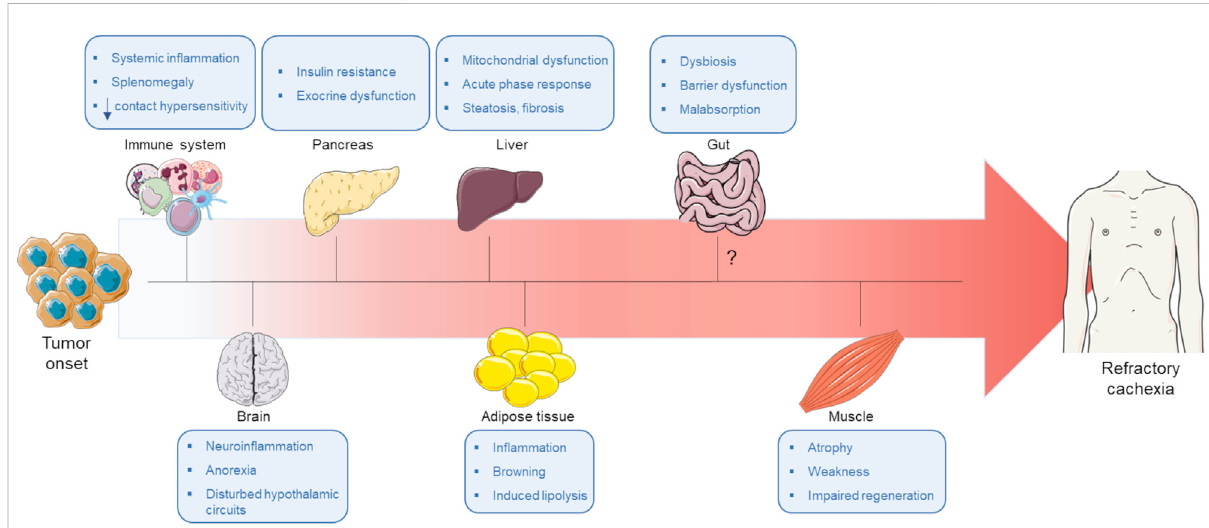
FIGURE 1 Hypothetical temporalmodelforcachexiaprogressionbyintegrating fi ndingsfrompreclinicalmodelsandpatients.Basedonthedatareported in literature, we suggest a timeline of organs/tissuesderangement upon cachexiaprogression, highlighting that skeletal muscle wasting, considered asoneofthemainpathologicalprocessesincachexia,appearstobealateevent.Inresponsetotumorgrowth,the fi rstaffectedtissueistheimmune system, which is a central player in the cachectic process and in the establishment of systemic in fl ammation. Similarly, several reports indicate that appetite loss is an early event in cachexia progression and although the cause of anorexia is still elusive, in fl ammatory mediators and tumor- derived factors appear to play key roles in the loss of appetite. Another early event in host adaptation to tumor development is the derangements of both endocrine (insulin resistance) and exocrine functions of pancreas, affecting both tumor growth and cachexia development. Accordingly, pancreaticenzymesalterations havebeendirectlyassociatedtoadiposetissuewasting,evidencingthatitcanbeanearlyeventincancer-associated cachexia. A couple of studies indicate that some alterations in liver, such as mitochondrial dysfunctions and acute phase response, might also intervene early after tumor initiation while steatosis and fi brosis appear later. The most investigated tissues in cachexia, adipose tissue and skeletal muscle, engage a tight crosstalk, with alterations in adipose tissue preceding skeletal muscle wasting. Lipolysis triggered by different stimuli, such as pro-in fl ammatorycytokines,inducesthereleaseoffree-fattyacidsincirculation.Theexcessiveoxidationoffree-fattyacidsinskeletalmuscleseems to be among the earliest events in prompting muscle wasting, supporting a functional and chronological link between lipolysis and muscle breakdown. Finally, alterations in gut homeostasis have been reported to deeply contribute to cachexia development, but it is not known in